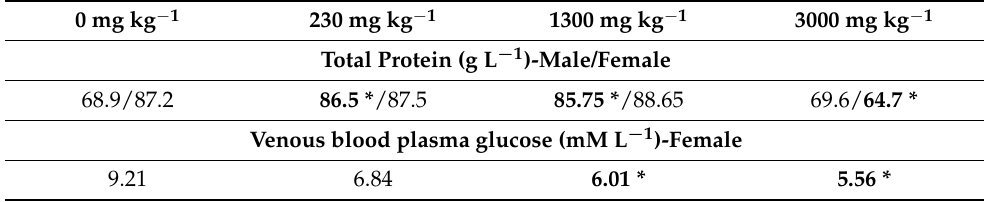
Table 1. Summary of mice reliable biochemical parameters changes (in the study of acute toxicity), median values are presented. * p < 0.05 (Kruskal-Wallis One-way ANOVA test).